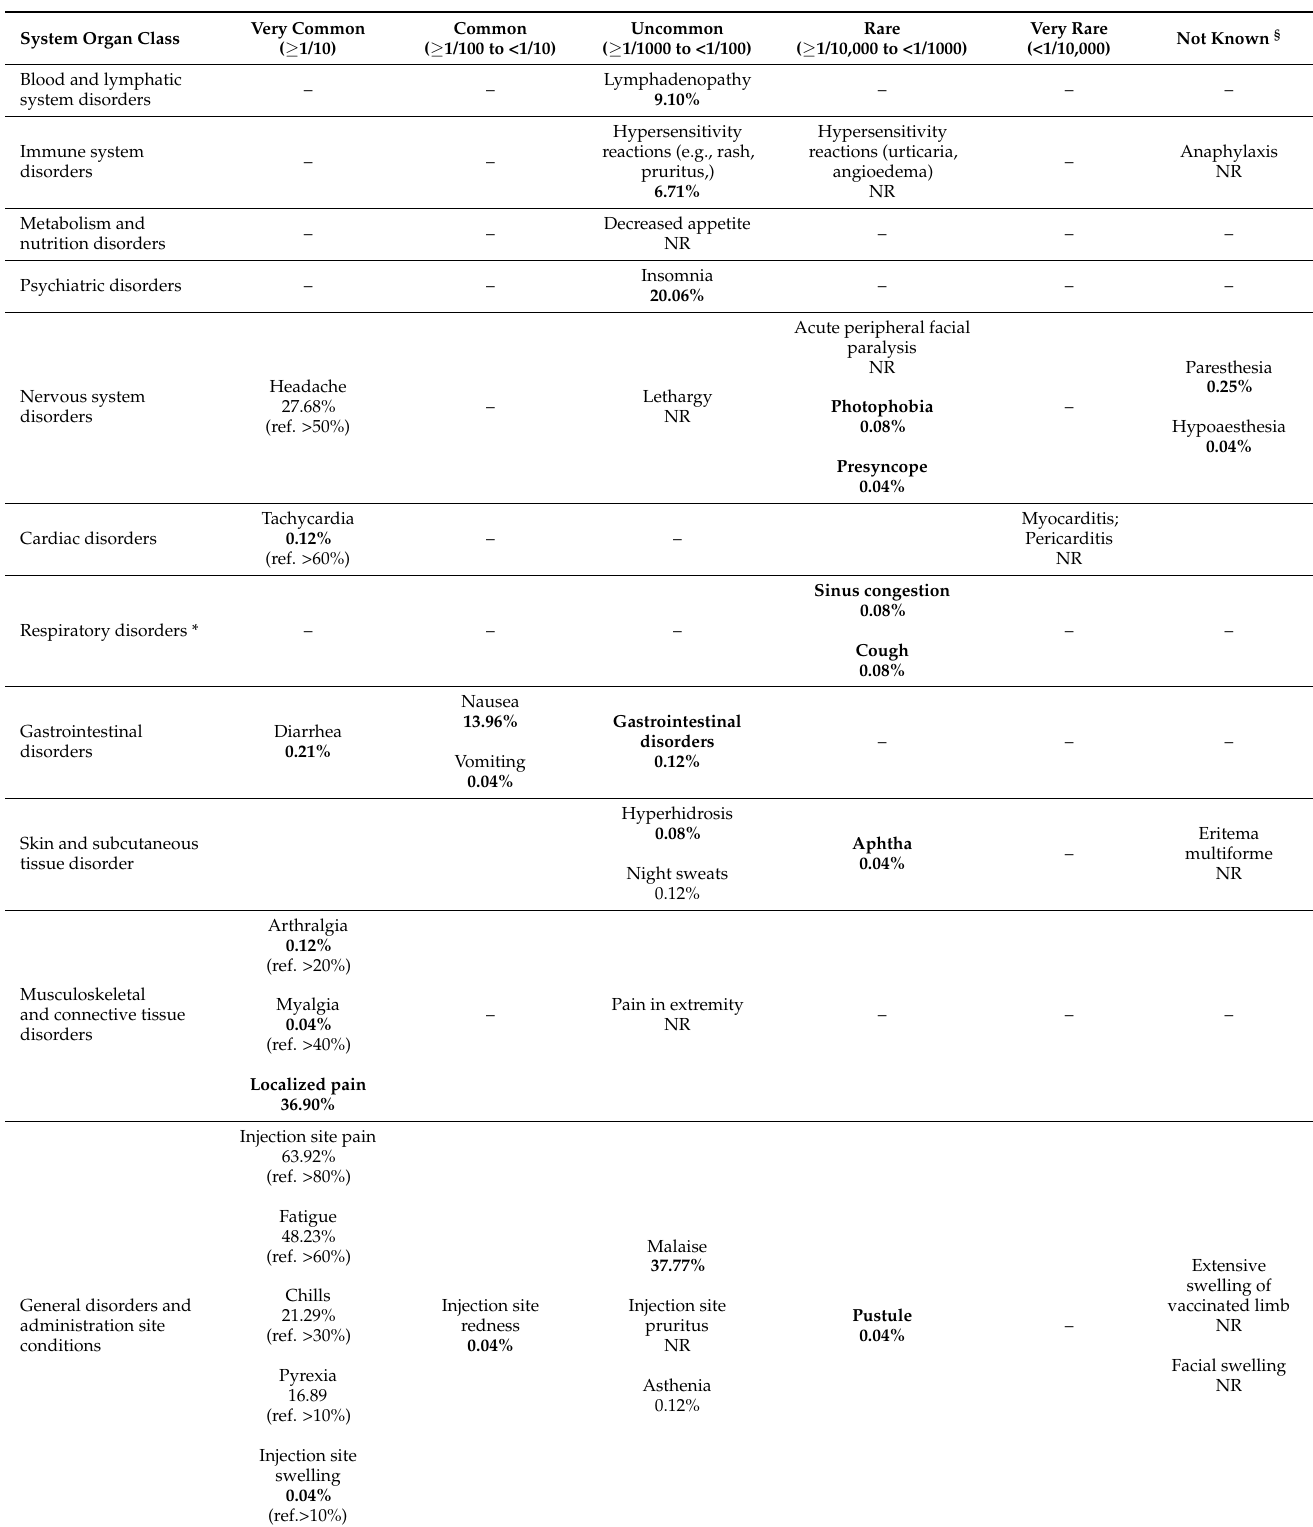
Detailed FPG safety results compared to the SPC of Comirnaty